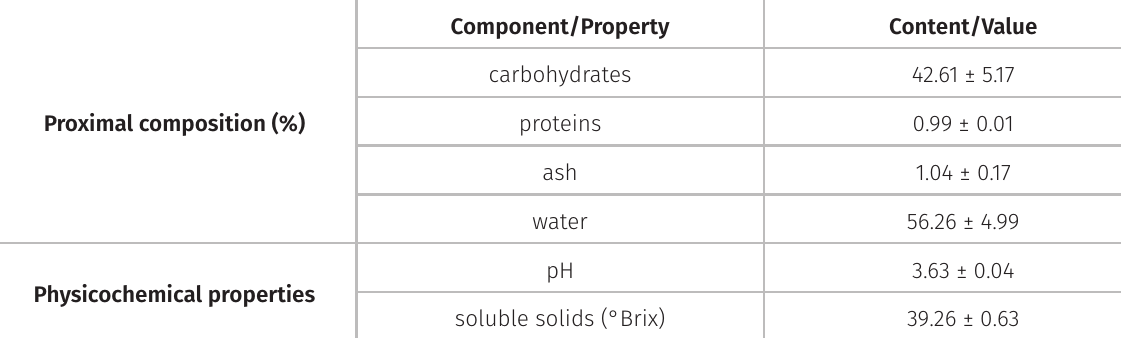
Table I. Proximal experimental composition and other physicochemical properties of Red Globe low-calorie grape